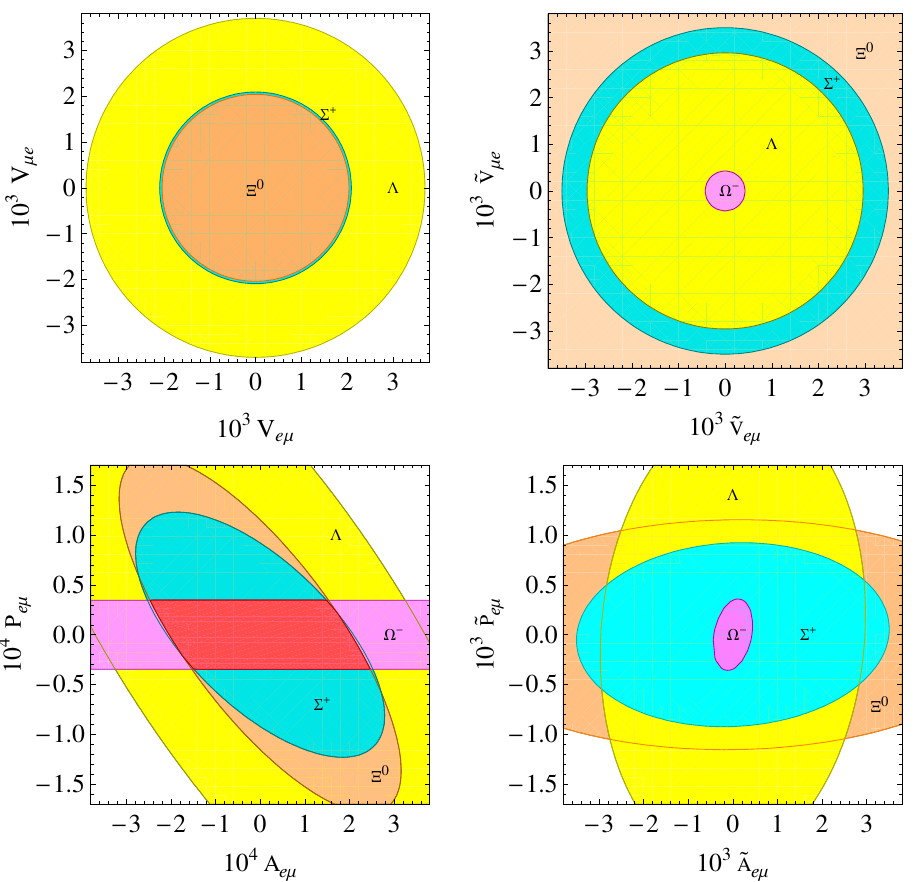
Figure 2 . Allowed regions of V versus V (top left), ˜ v versus ˜ v (top right), P versus A µe eµ µe eµ eµ eµ (bottom left), and ˜ p and ˜ a (bottom right), all taken to be real, for Λ np = 1 TeV, subject to eµ eµ 10 on the hyperon branching fractions in eqs. (3.1)–(3.4), labeled by Λ, Σ + , assumed limits of 10 − , respectively. The bottom plots take into account eq. (1.7). In each case the other Ξ 0 , and Ω − couplings are set to